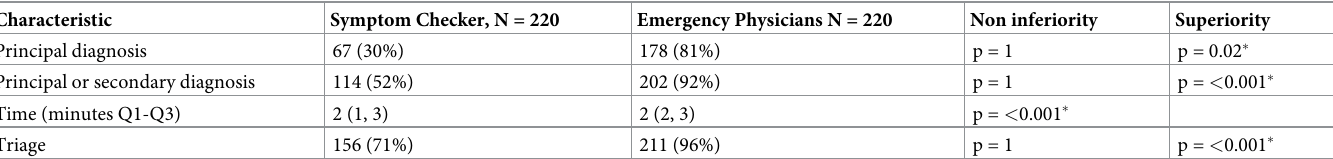
Table 3. Non-inferiority and superiority